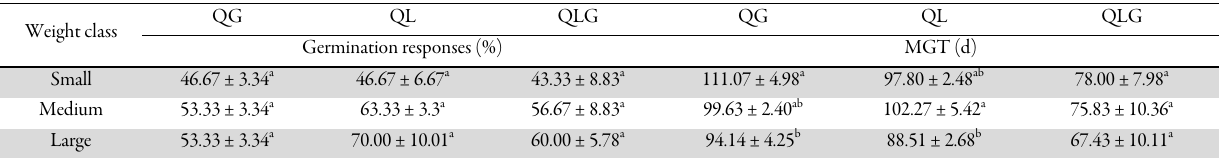
Table 3. Effects of seed size on mean germination and MGT in three oak species in Kumaun, West